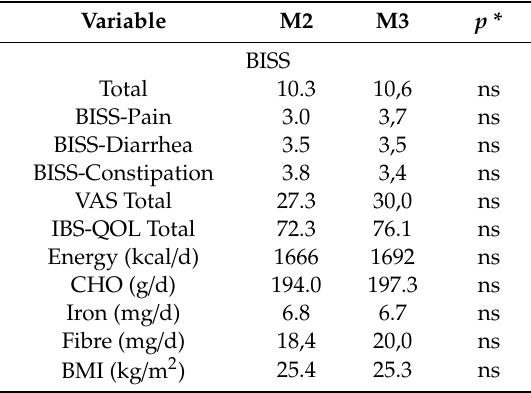
Table 5. LFD Group: 10-week